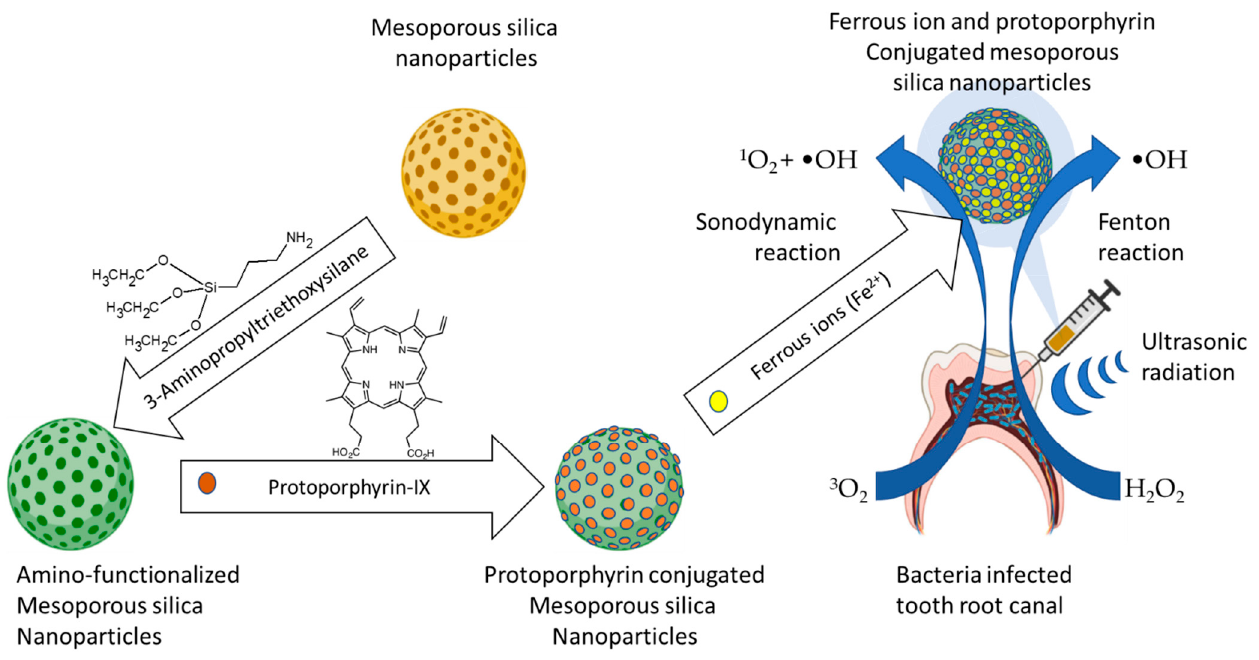
Figure 4. Illustration of the Fenton reaction-enhanced SDT, a combination of SDT with the Fenton reaction generation of hydroxyl radicals (Guo et al., 2021) [152].